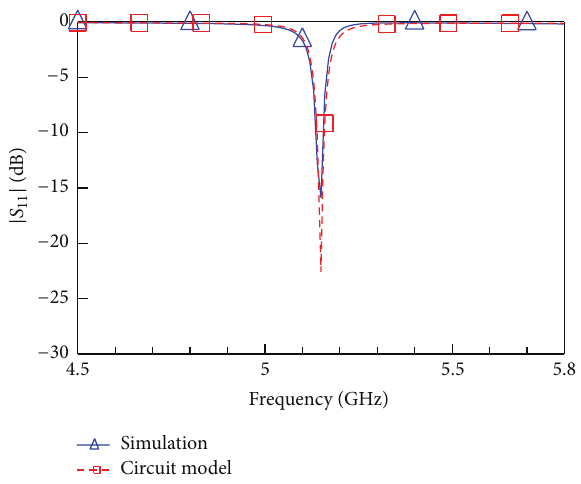
Figure 21: Comparison of circuit model and simulated reflection coefficient results of miniaturized patch antenna loaded with CSRR.